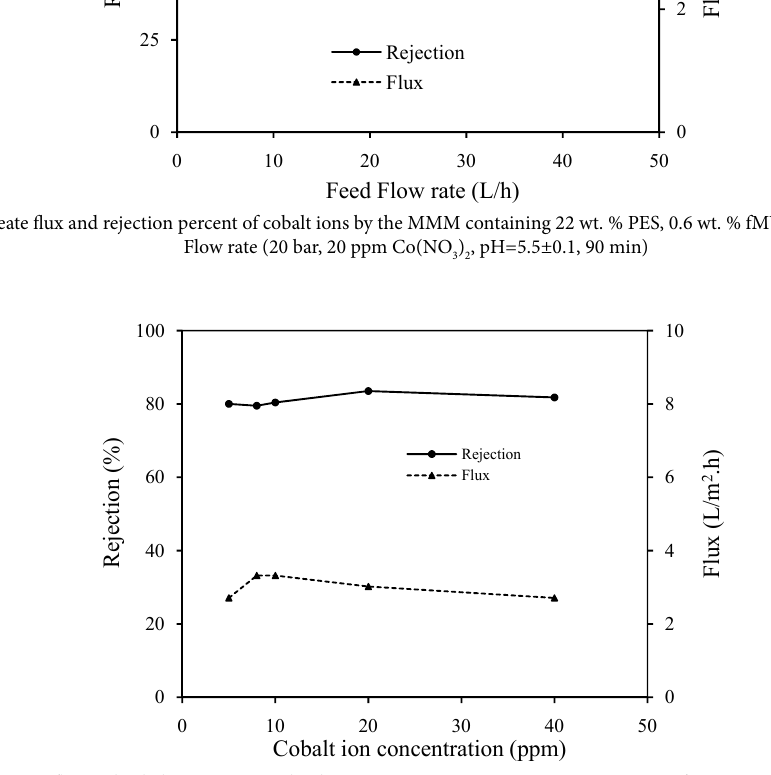
Fig. 9. Permeate flux and cobalt ions rejection by the MMM containing 22 wt. % PES, 0.6 wt. % fMWCNTs versus cobalt ion concentration in feed solution (20 bar, 40 L/h, pH=5.5±0.1, 90 J. Water Environ. Nanotechnol., 4(2): 97-108 Spring 2019